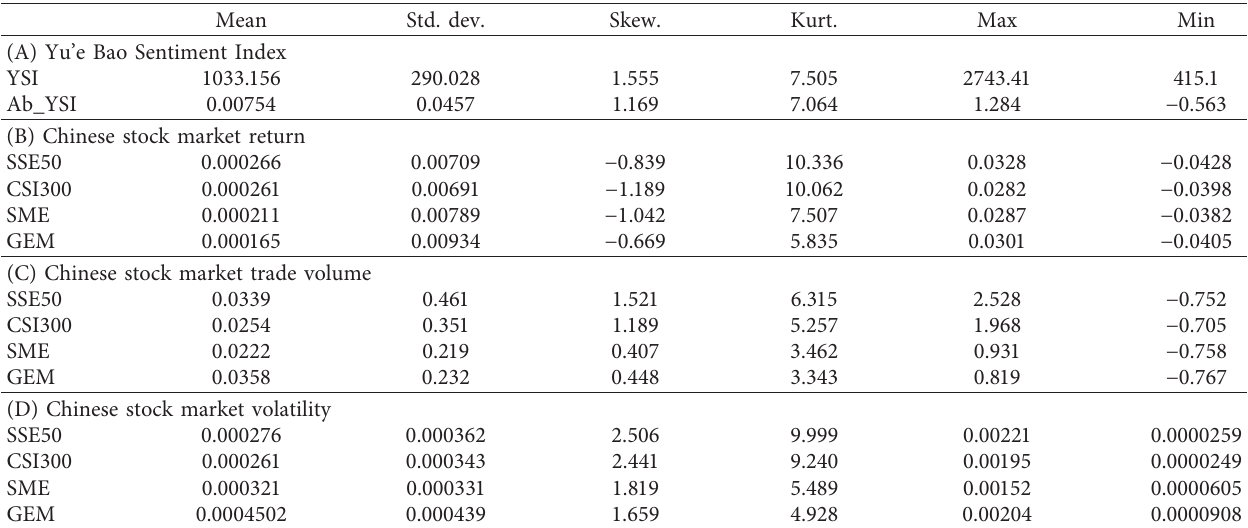
Table 1: Summary